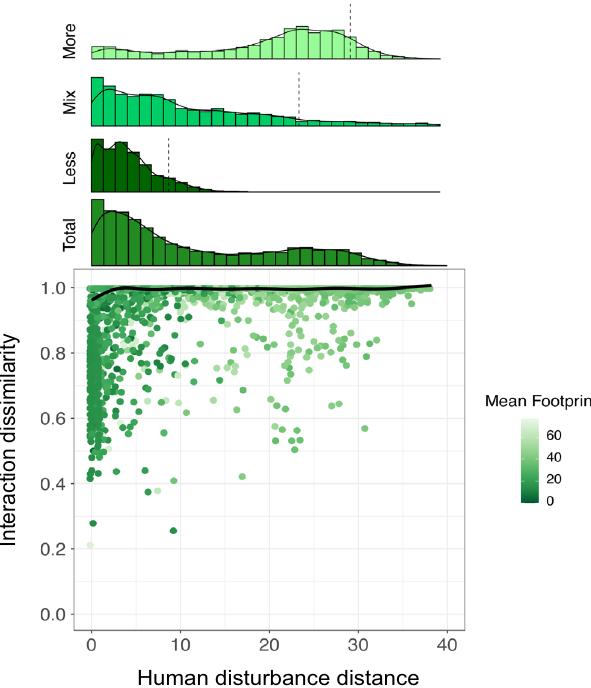
Fig. 5 | The effect of human disturbance gradients on interaction dissimilarity ( β WN ). The relationship between human disturbance distance and interaction dis- similarity,witha fi ttedlineobtainedfromaGeneralizedAdditiveModel(GAM)with human disturbance distance as the only predictor variable (Supplementary Fig. 13 shows the partial effects plot for the model including all predictors). Human dis- turbance distance was calculated as the absolute difference in human footprint valuesbetweenapairofnetworksites.Eachdatapoint(pairofnetworks)iscolored according to the mean of the human footprint values from the two networks. The histogram above the plot shows the distribution of data points across the human disturbance gradient. To explore whether disturbance distance and the mean intensity of disturbance are related, we further divided our data into three equal sizedgroups(topthreehistograms)basedontheirmean(ofthesitepair)footprint values: “ Less ” disturbed (low mean footprint), ‘ Mix ’ (medium mean footprint) and ‘ More ’ disturbed (high mean footprint). Dashed lines mark the 90th percentile position in each histogram.Note thatdata points from less disturbed site pairs are skewed towards low values of human disturbance distance, whereas pairs of more disturbed sites also had a larger average distance. Source data are provided as a Source Data fi